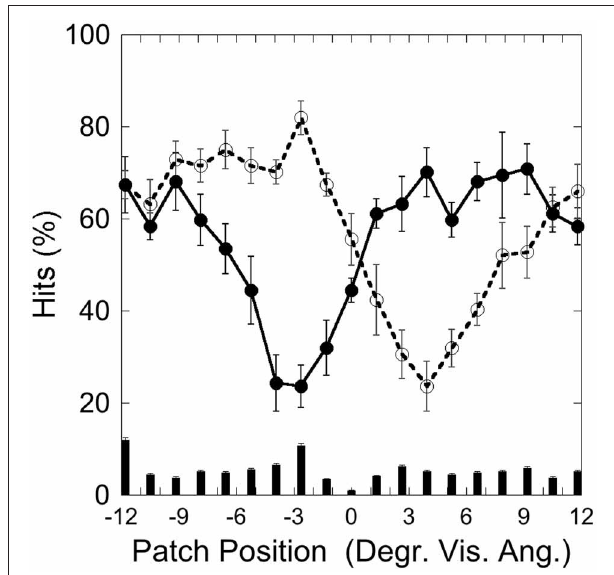
FIGURE 6 | Experiment 2: hits and false alarms averaged over patch color conditions as a function of patch position. Solid line, filled circles show hits on the target at − 3 . 9 ◦ , dotted line, unfilled circles show hits on the target at + 3 . 9 ◦ . The columns on the bottom depict false alarms as a function of patch position. Black bars depict standard errors.